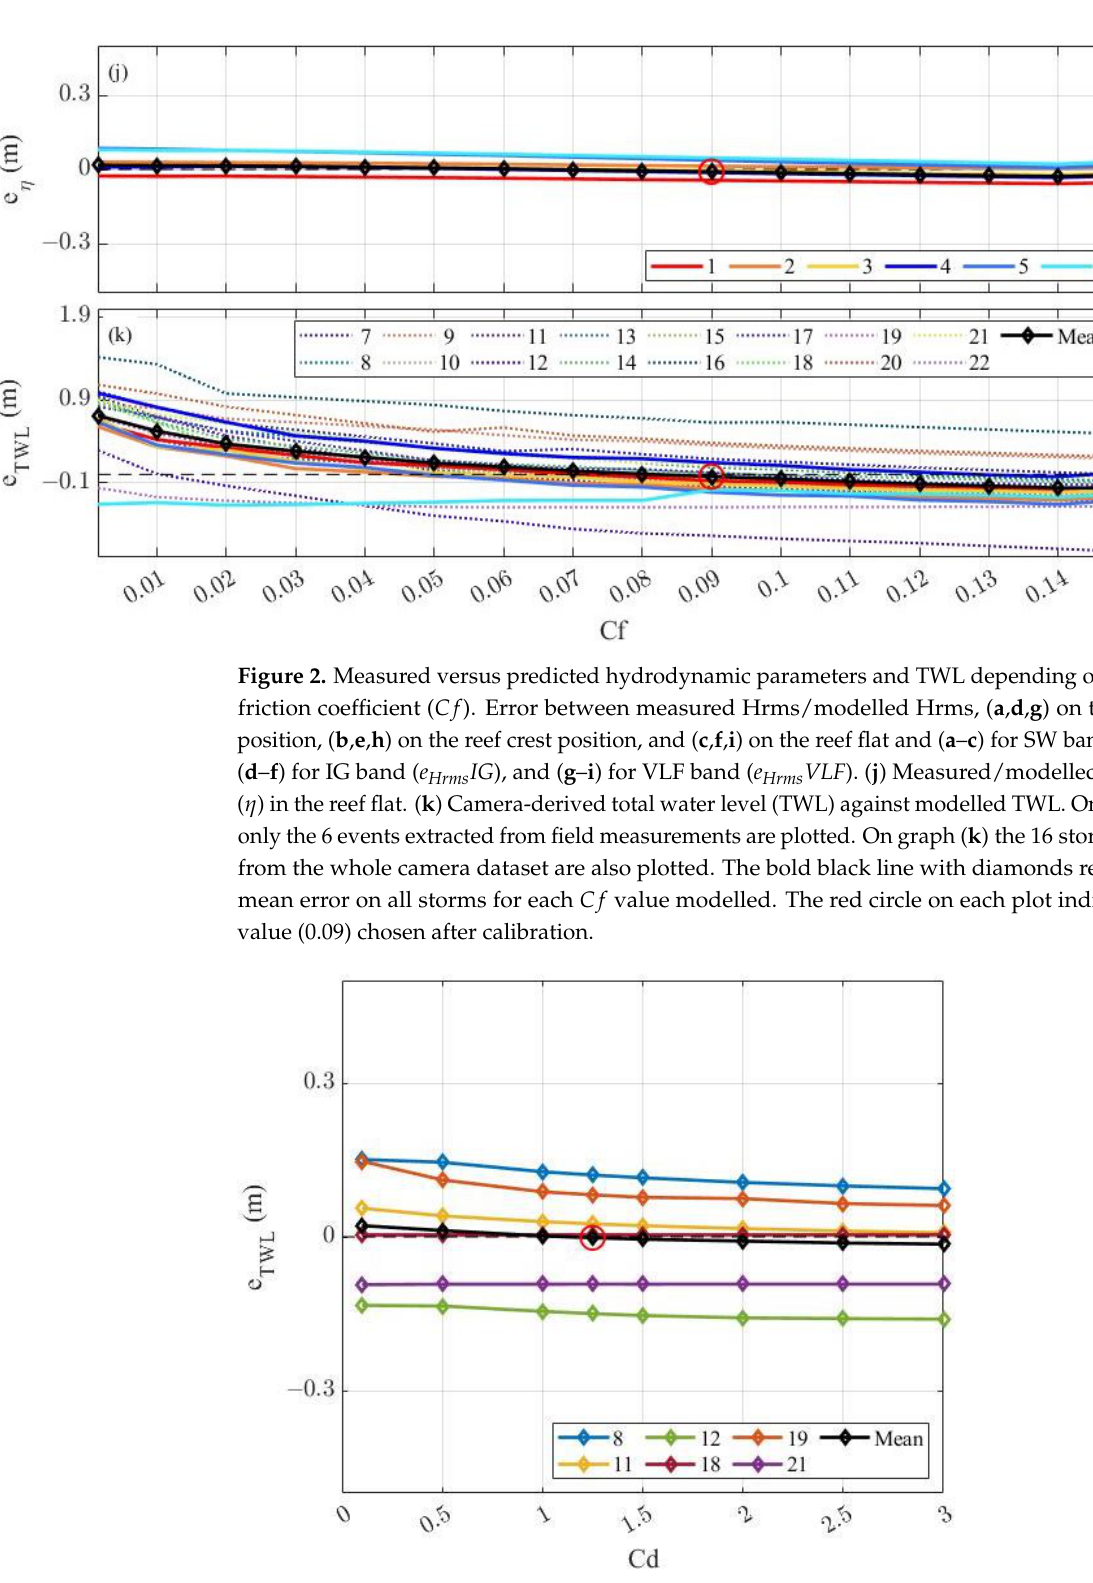
Figure 3. Total water level (TWL) error for the event exceeding the vegetation, and the mean error for each drag coefficient ( Cd ) coefficient value